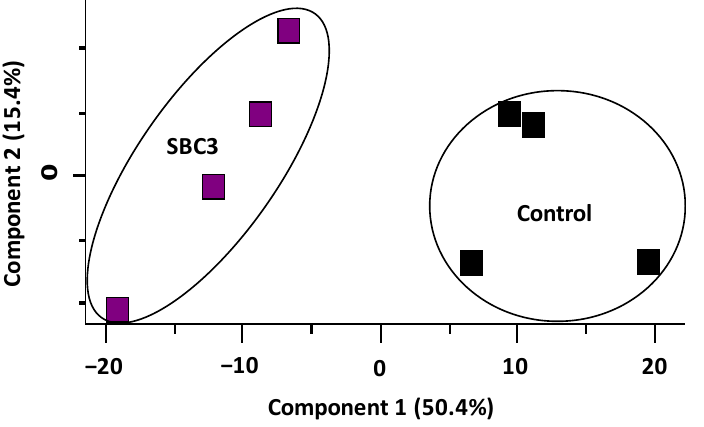
Figure 4. Principal component analysis (PCA) of SBC3-treated S. aureus versus untreated control samples.